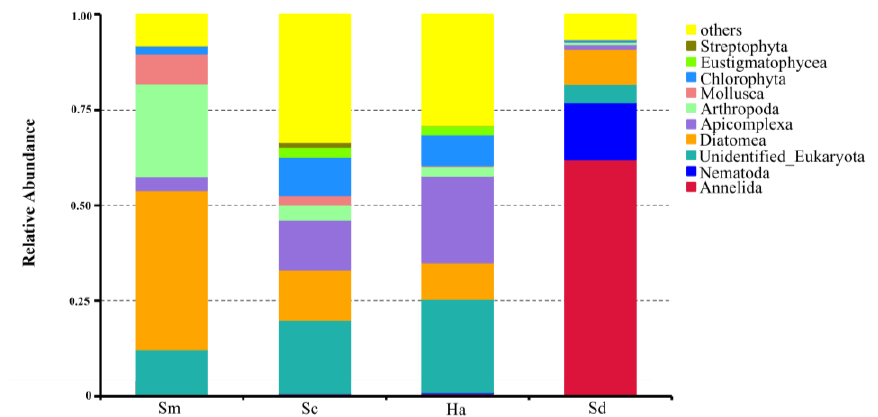
Figure 4. Relative abundance of the 10 most abundant phyla of S. monotuberculatus (Sm), S. chloronotus (Sc), H. atra (Ha) and the surrounding sediments (Sd). Others indicate all reads except the top 10 phyla.